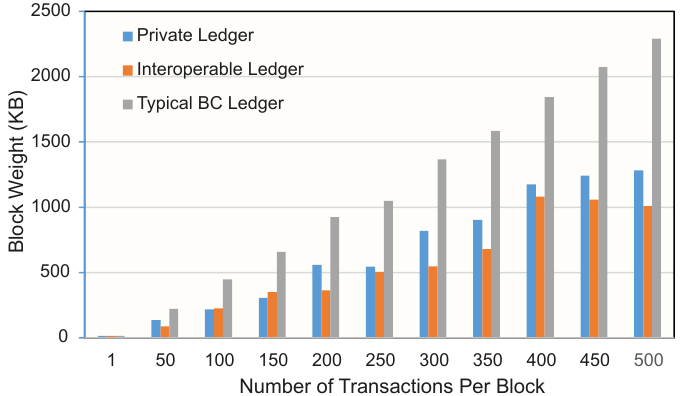
Figure 5. Scalability of transactions.